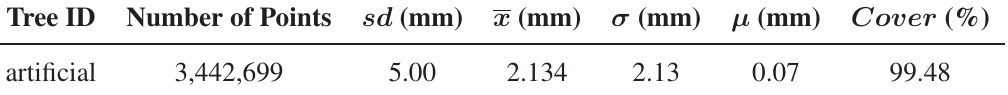
Table 7. Distance analysis between the point cloud and the derived model for the artificial